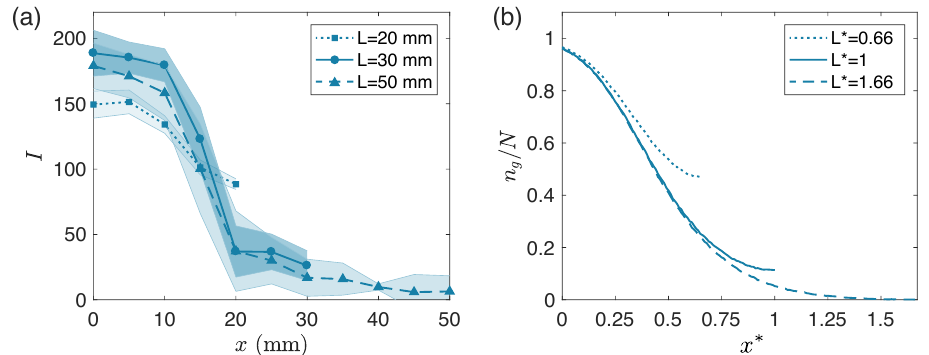
Figure 5. ( a ) Experimental measurements of fluorescent intensity profile at 16 h for three differ- ent secondary interior chamber lengths. Interior secondary chamber dimensions: L × w × h = L × 30mm × 1mm, with L = 20 mm, 30 mm, or 50 mm. Shaded regions on each side represent one standard deviation of measurements obtained from at least three independent experiments. ( b ) Prediction of model at t ∗ = 5.00 for three different domain lengths with P g = 5 × 10 − 4 , w ∗ = 1, h ∗ = 0.03, ˙ m ∗ = 1000, and L ∗ = 0.66, L ∗ = 1, or L ∗ = 1.66. Each curve represents the average